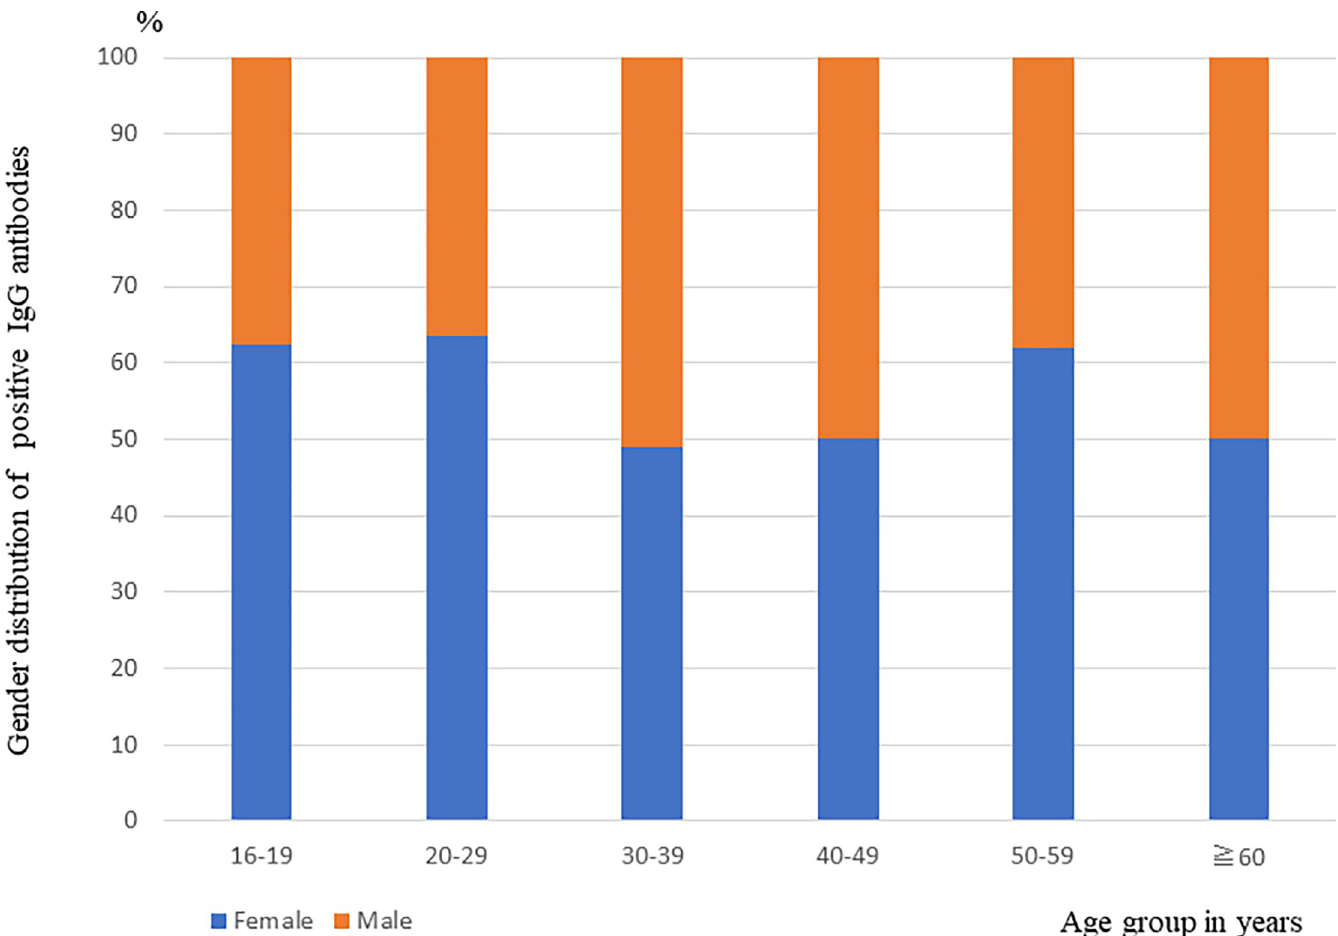
Fig 2. Age distribution of IgG-positive cases stratified by sex: East Java, Indonesia (n = 207 cases).